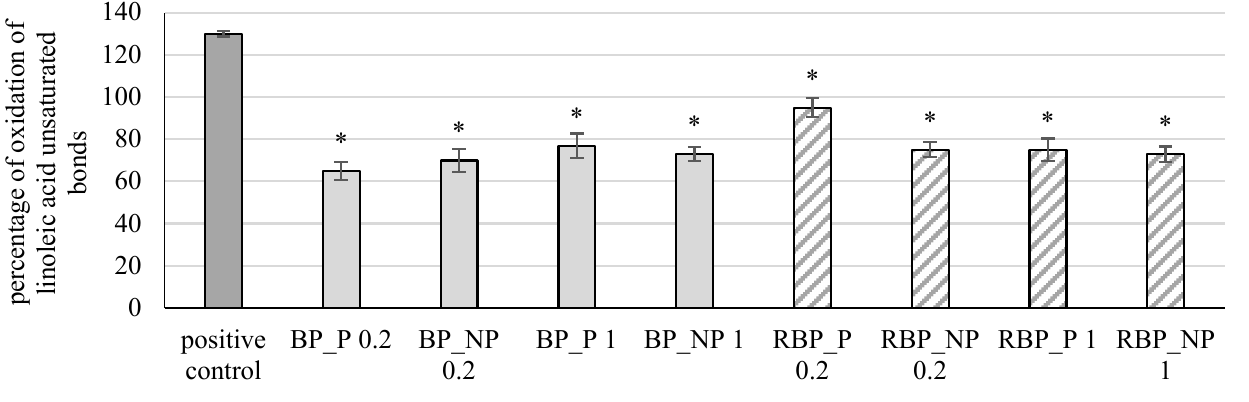
Figure 6. Effect of banana and red beetroot peel extracts on damage of linoleic acid. Results are presented as the mean value +/ − standard deviation of 3 independent experiments. BP_P ‐ banana peel extract with polysaccharides; BP_NP ‐ banana peel extract without polysaccharides; RBP_P ‐ red beetroot peel extract with polysaccharides; RBP NP-red beetroot peel extract without polysaccharides, concentrations 0.2 and 1 mg mL − 1 ; *—statistically significant ( p < 0.05) difference in comparison to positive